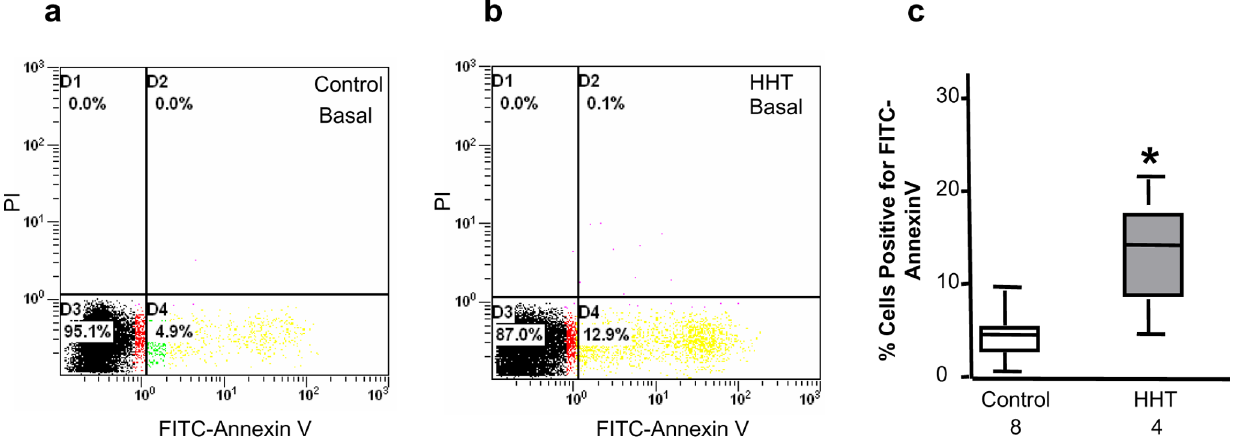
Figure 3. Elevated basal cell apoptosis levels in CACs from HHT patients. Basal cell apoptosis in CACs after a 7-day culture was analyzed by Annexin V staining and flow cytometry. A representative dot plot of flow cytometric analysis for healthy and HHT CAC apoptosis was shown in panels a and b, respectively. Statistic analysis demonstrated that the levels of basal cell apoptosis in CACs from HHT patients were significantly higher than those in CACs of healthy individuals (c). * p , 0.05, compared with healthy controls.